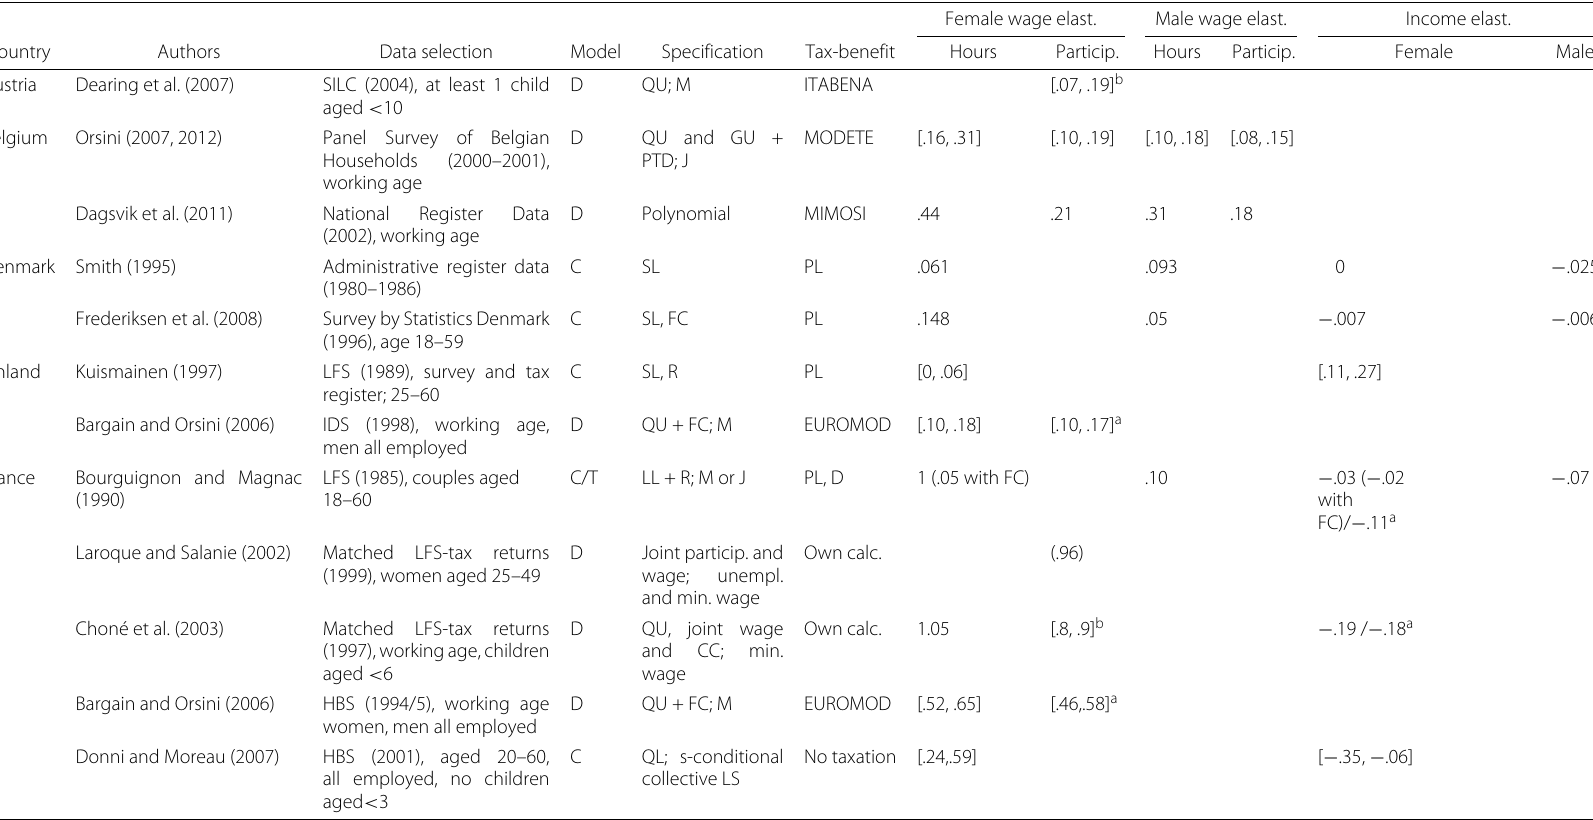
Table 1 Labor supply elasticities in Europe: couples